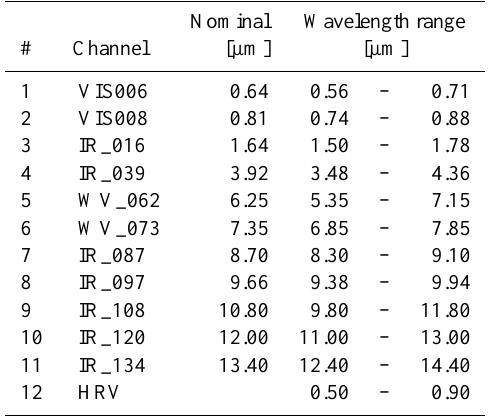
channel at 3.9 µm (see Table 1). The spectral coverage of the channels is shown in Fig. 1. The spatial resolution is 3 km × 3 km at the sub-satellite point, except for the high- 1 km × 1 km at the sub-satellite